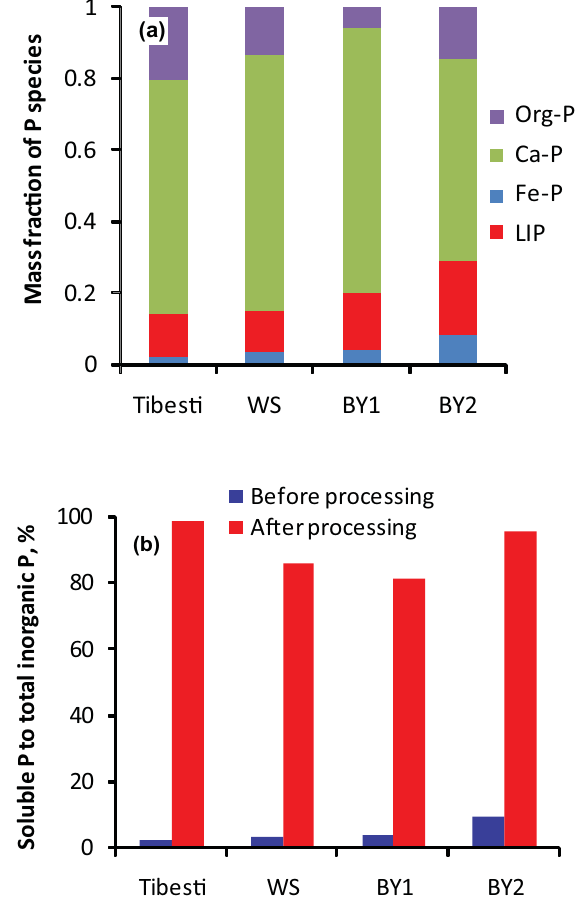
Fig. 3. (a) Phosphorus speciation in Saharan soil and natural Saha- ran dust. (b) The change in soluble P to total inorganic P as a result of simulated atmospheric processing at pH 2 for